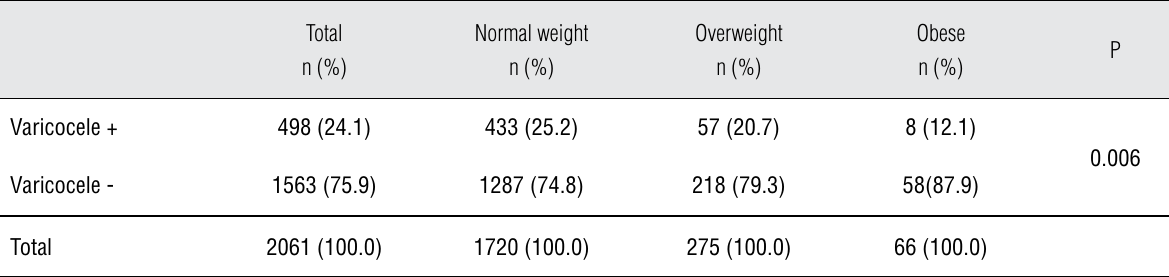
Table 2 - The relationship between presence of varicocele and obesity.